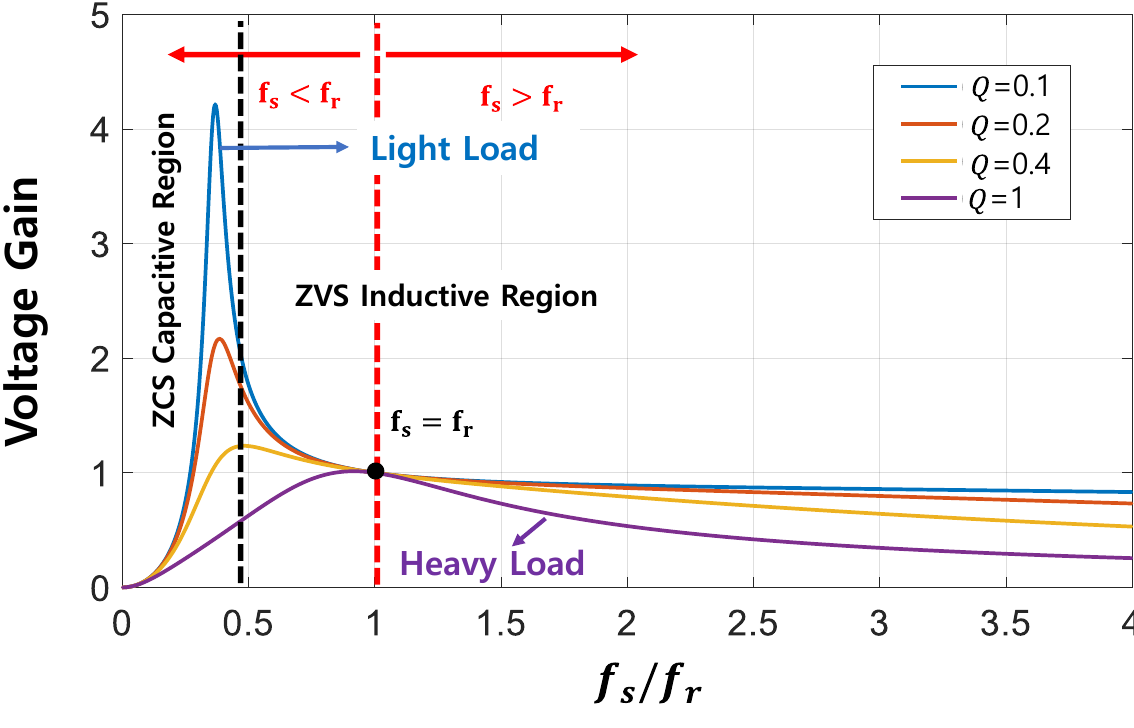
Figure 4. Voltage gain curve.